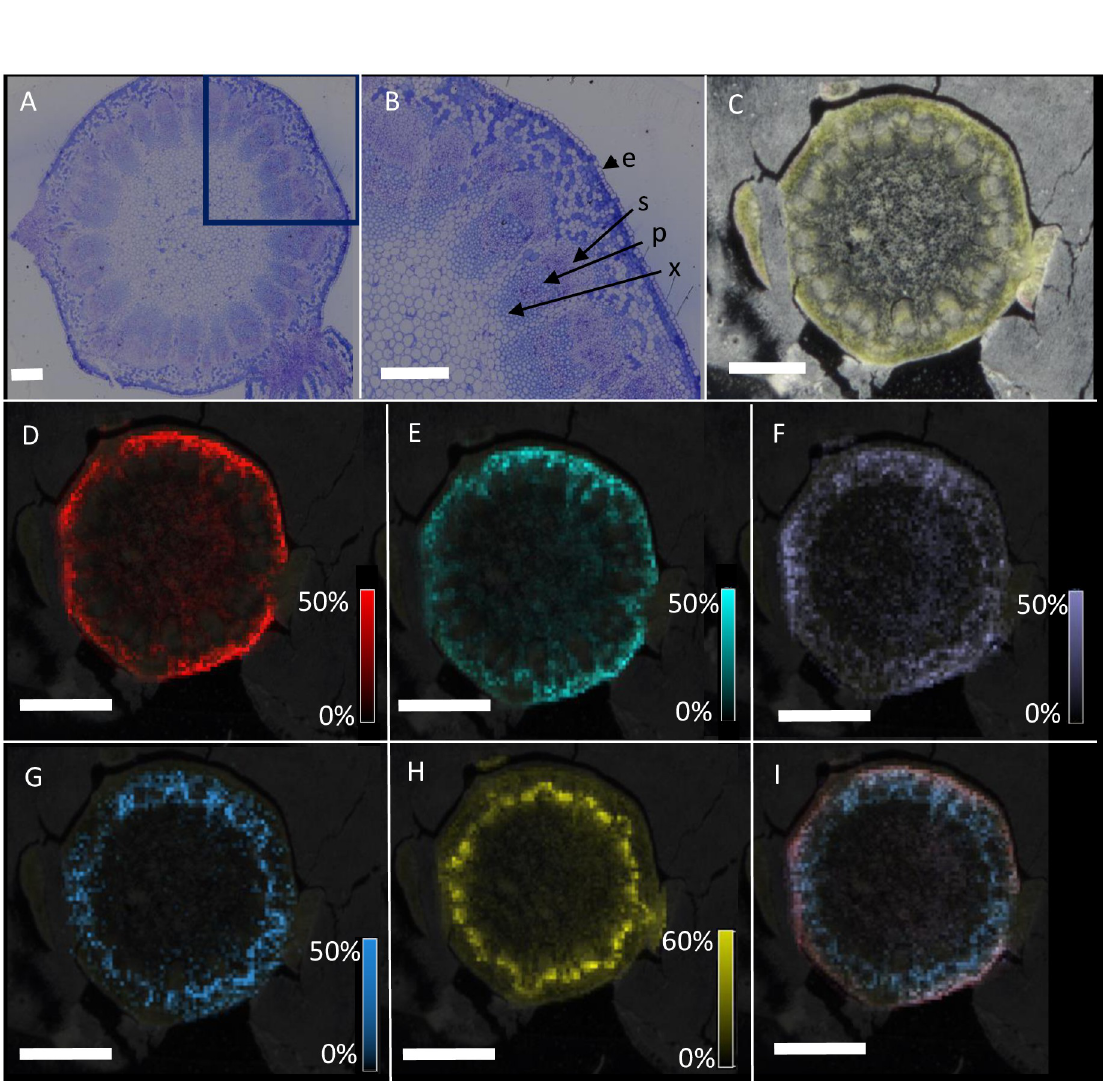
Fig 5. Light microscopy and MALDI-MS images of transverse section of Hakea bucculenta rachises. (A) Light microscopy image of rachis transverse section. (B) inset of rachis vasculature (box from A), where e is epidermis, x–xylem, p–phloem, s–sclerenchyma. (C) Optical image of rachis transverse-section imaged by MALDI-MS (35 μ m thick). (D) dhurrin [M + Na] + ( m/z 334.0896, Δ m 0.3 mDa), (E) dhurrin [M + K] + ( m/z 350.0635, Δ m 0.6 mDa), (F) proteacin [M + Na] + ( m/z 496.1421, Δ m 0.8 mDa), (G) proteacin [M + K] + ( m/z 512.1164, Δ m 0.2 mDa), (H) hexose [M + K] + ( m/z 381.0792, Δ m 0.5 mDa), and (I) Merged positive ion MALDI-MS image of rachis transverse-section showing dhurrin and proteacin. All MALDI-MS images were obtained using 50 × 50 μ m array. White scale bars indicate 200 μ m for A-B, and 1 mm for C-I. Coloured intensity scales represent 0–50% TIC normalised signal intensity (0–60% for